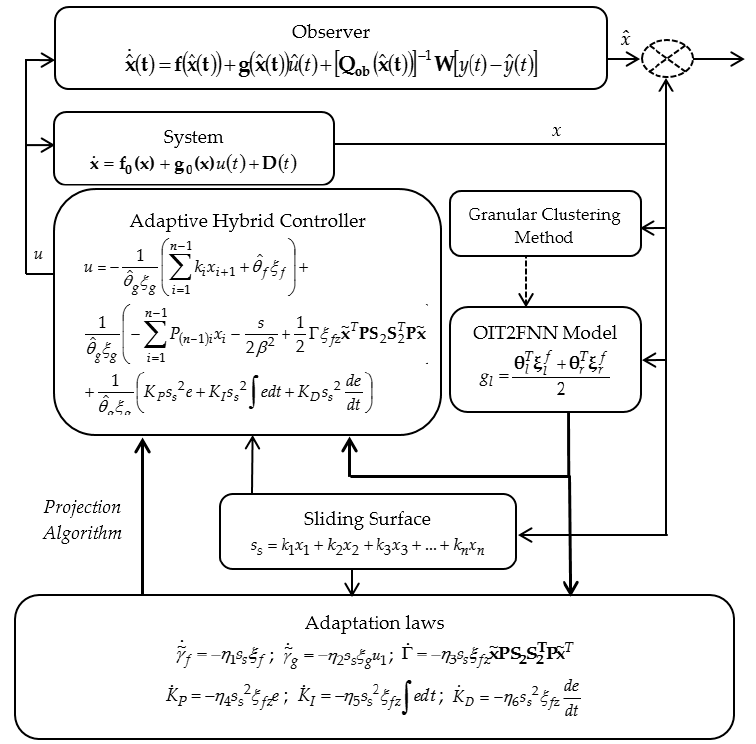
Figure 1. A closed-loop of the proposed hybrid controller.